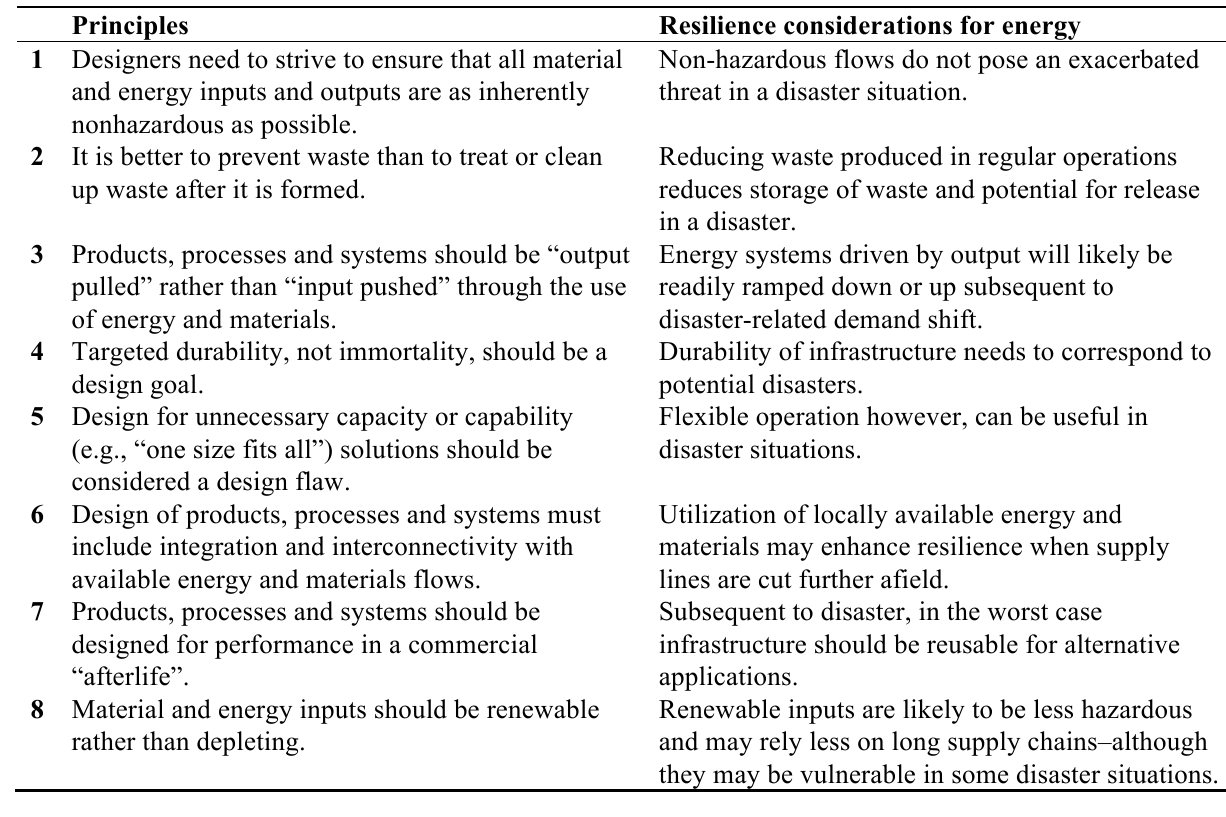
Table 1. Principles of “Green Engineering” [40] and considerations of resilient energy